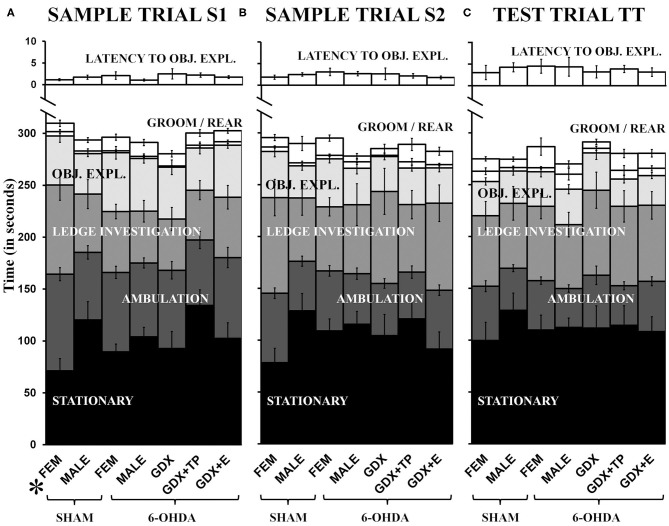
Stacked bar graphs showing average amounts of times in seconds, ± standard error of the mean, that rats spent stationary (black), ambulating (dark gray), engaged in ledge investigation (gray), object exploration (OBJ. EXPL., light gray), and grooming or rearing (GROOM/REAR) (white) during sample trial S1 (A), sample trial S2 (B), and the test trial TT (C). The average latency (in seconds) from trial start to exploration of a first object (LATENCY TO OBJ.EXPL.) is also shown in white above on different time scale. Comparisons from left to right show that with the exceptions of higher levels of S1 ambulation and lower levels of S1 stationary behavior in gonadally intact sham lesioned females (SHAM, FEM), rats in all other groups [gonadally intact, sham lesioned males (SHAM, MALE), MALE and FEM rats that were 6-hydroxydopamine-lesioned (6-OHDA), and 6-OHDA male rats that were gonadectomized (GDX), GDX and supplemented with testosterone propionate (GDX+TP), or GDX and supplemented with 17β-estradiol (GDX+E)] apportioned trial times similarly. The post-hoc comparisons performed after the identification of significant main effects of Group and significant interactions between Behavior and Group for MALE/FEMALE comparisons for S1 showed that these effects were driven by significantly increased ambulation and decreased stationary behavior in SHAM operated FEM compared to SHAM operated MALES (p = 0.002, 0.012).